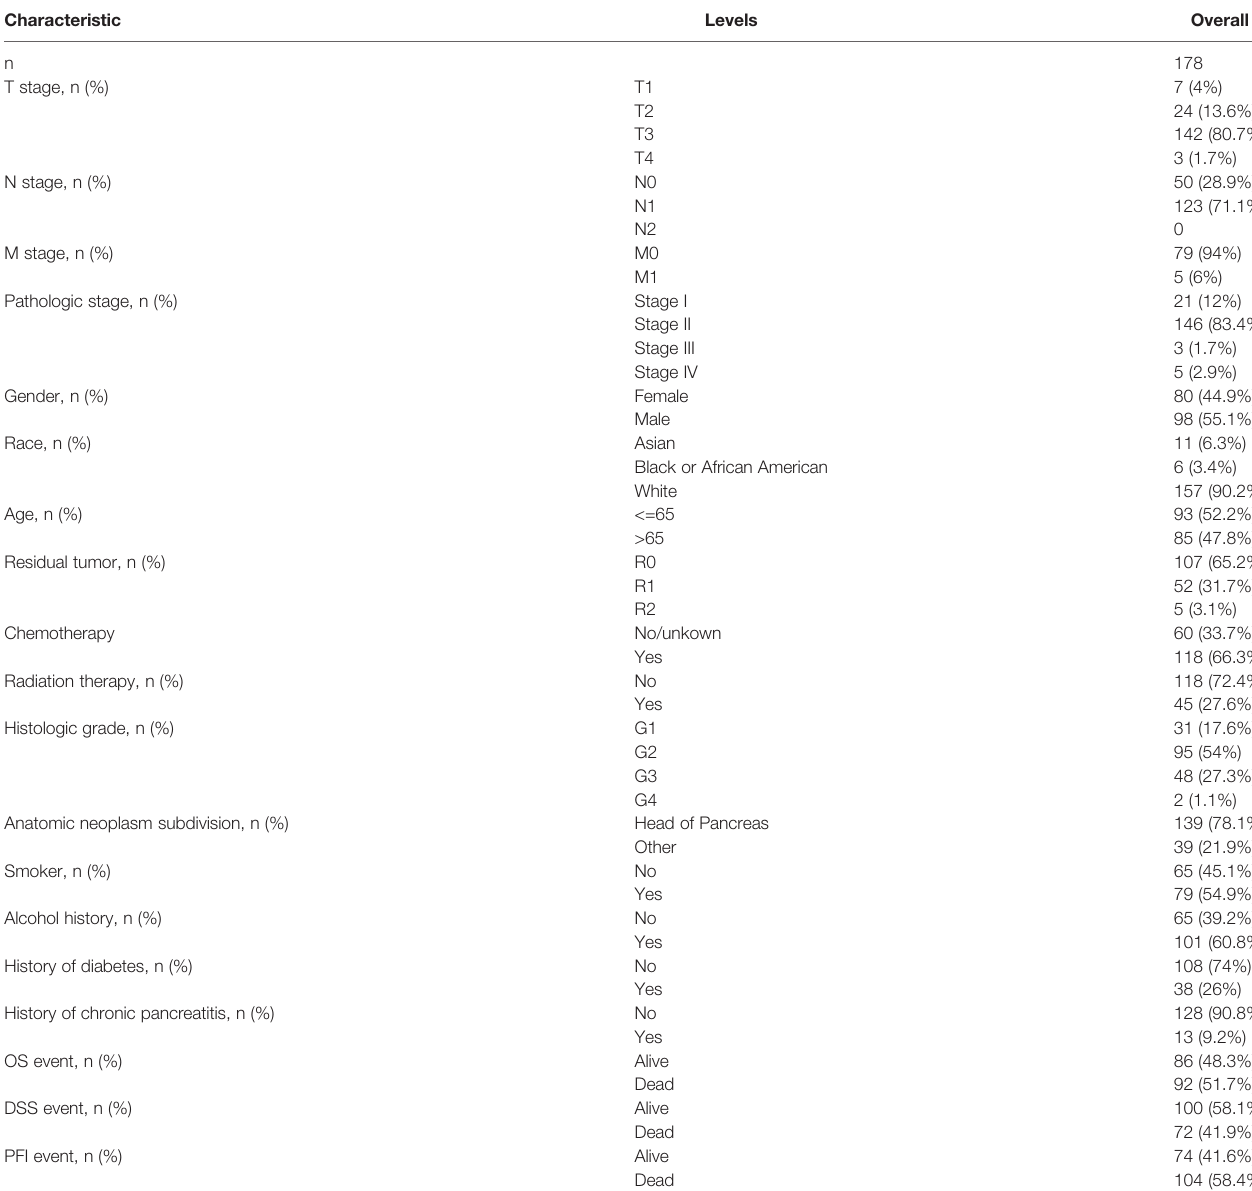
TABLE 1 | Baseline characteristics for patients with pancreatic cancer from TCGA. Characteristic